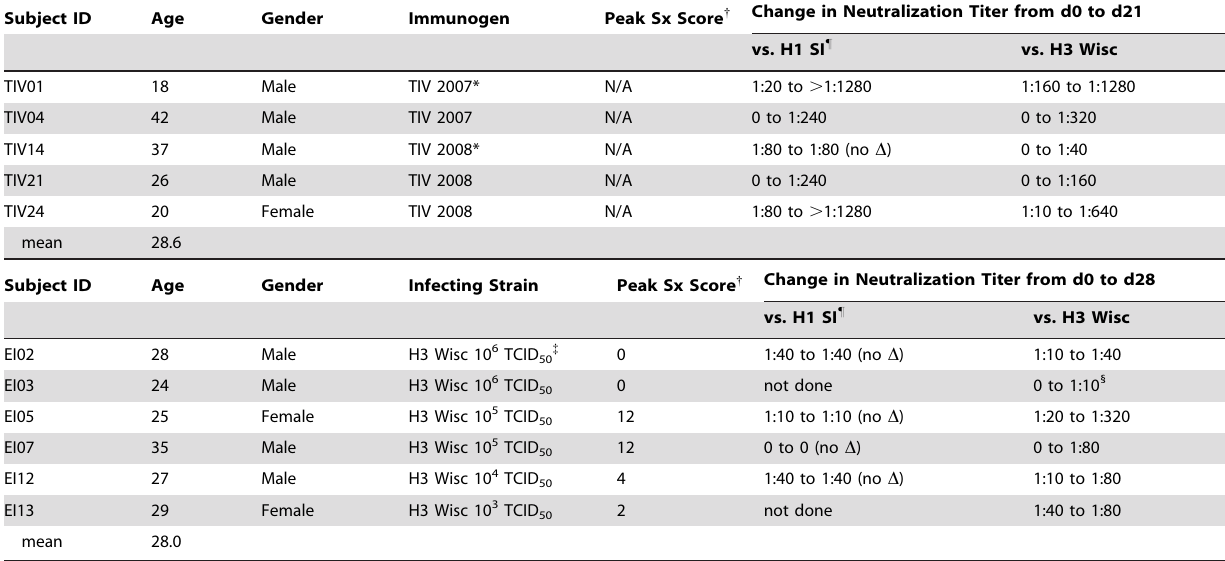
Table 1. Subject